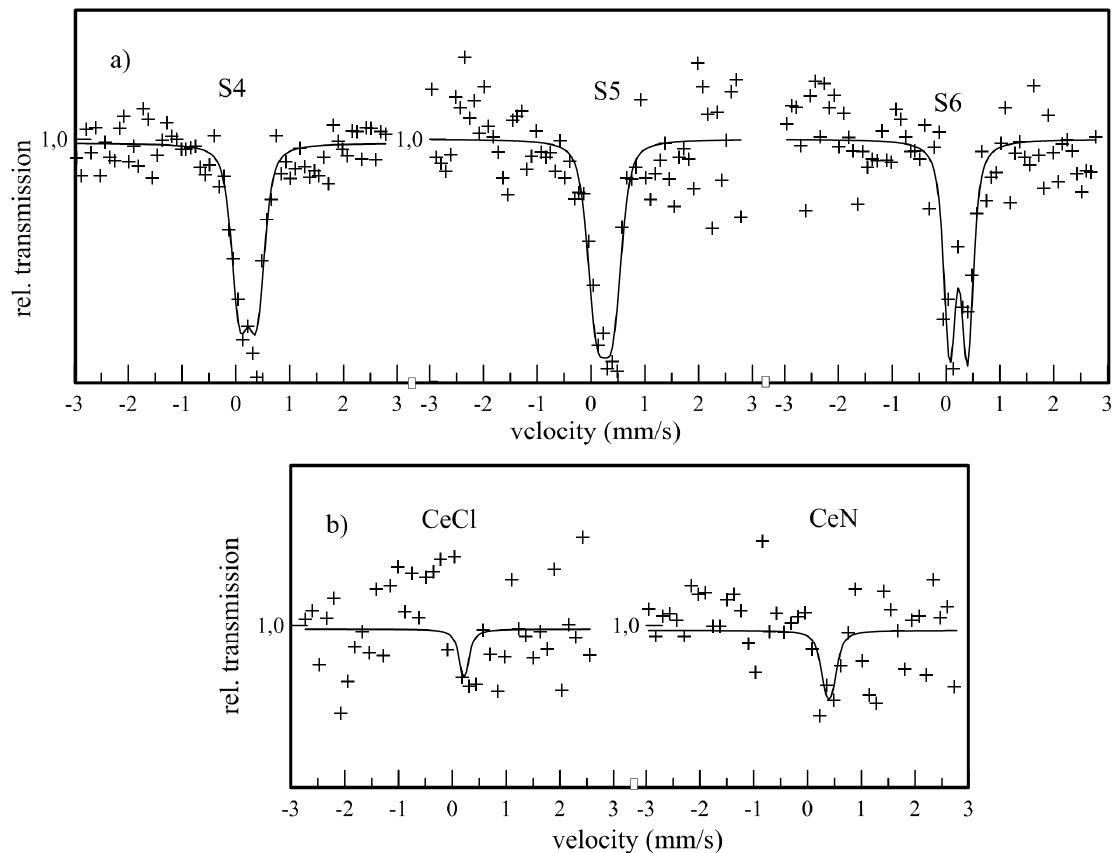
Figure 5. Room temperature Mössbauer spectra ( a ) of the S4, S5, and S6 samples prepared from different chemicals and ( b ) of selected chemicals, cerous chloride (CeCl) and cerous nitrate (CeN).